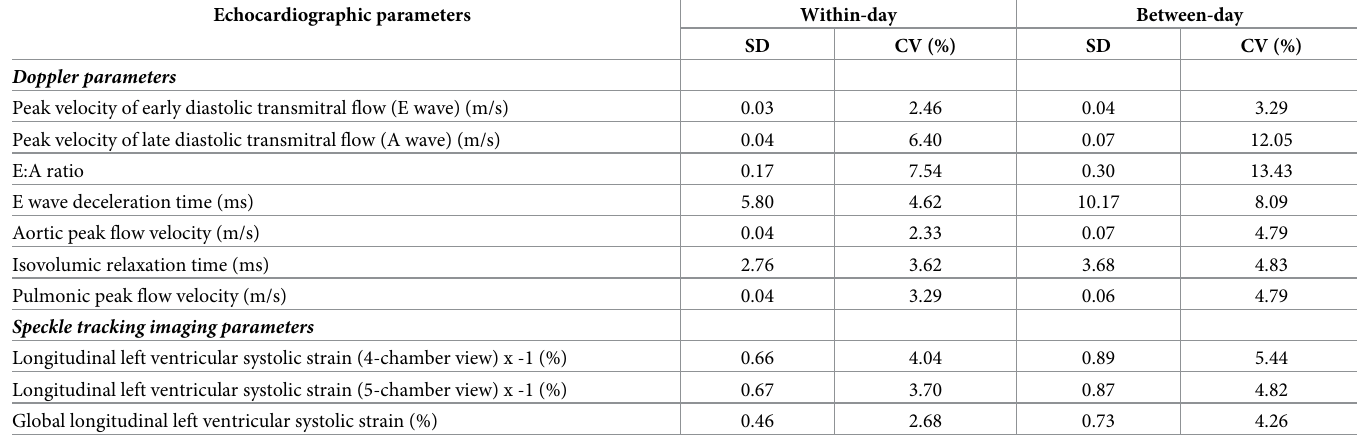
Table 4. Within-day and between-day variability, expressed as standard deviations (SD) and coefficients of variation (CV), of Doppler (n = 7) and STE (n = 3) vari- ables (n = 10) obtained by a trained observer in 4 Borneo orangutans ( Pongo pygmaeus pygmaeus ) from 96 transthoracic examinations. Echocardiographic